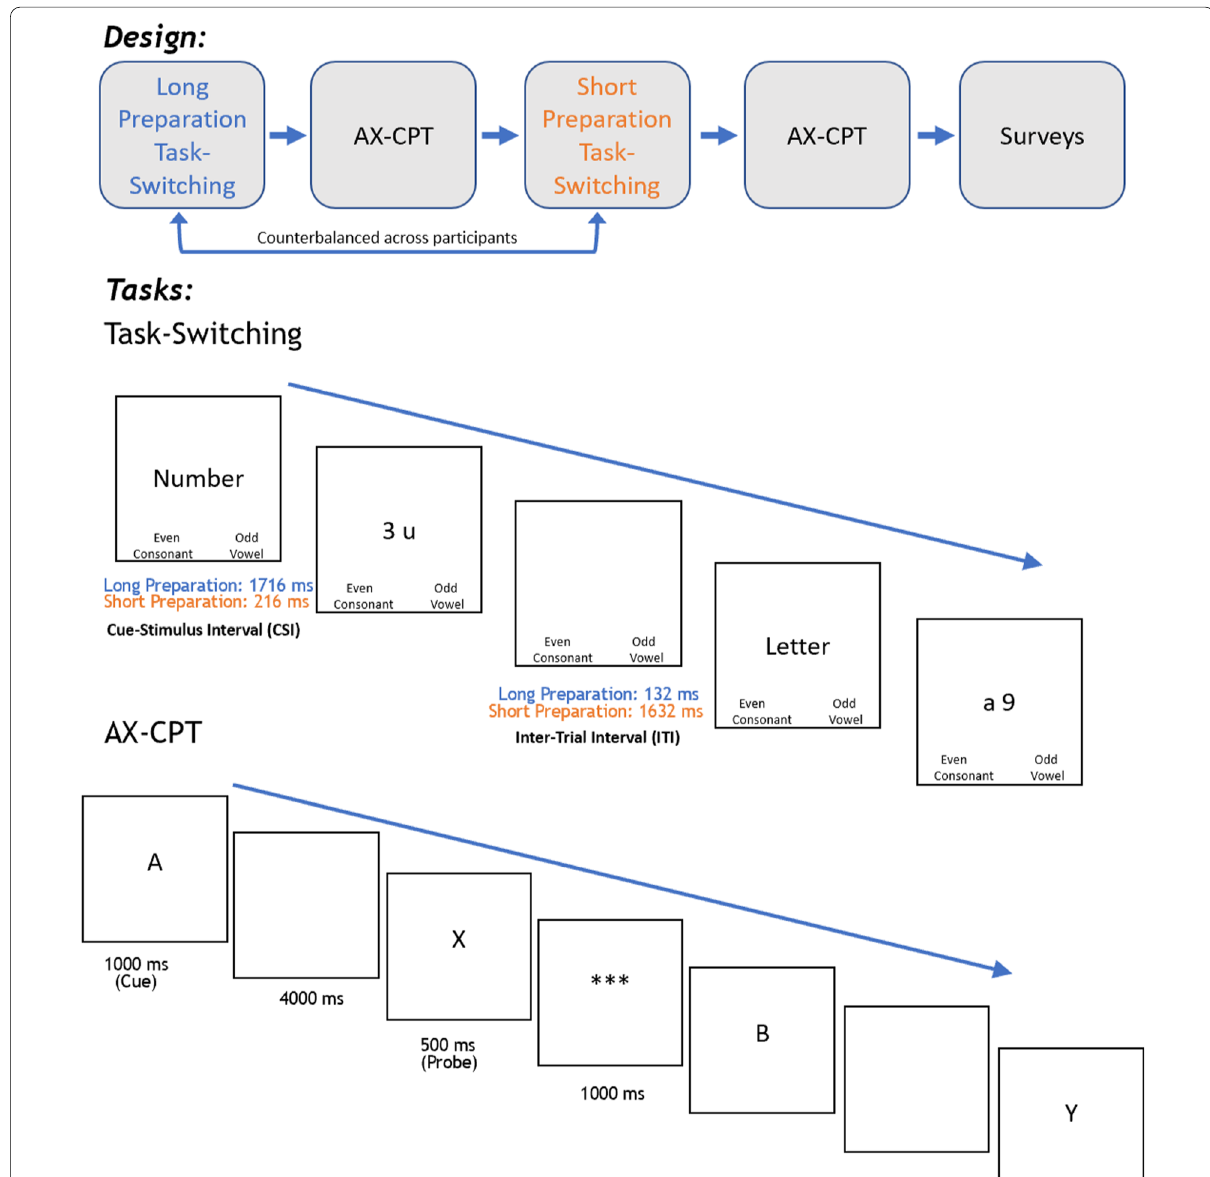
Fig. 1 Task design for the Pilot Study. Cue timings for the long preparation condition are indicated in blue text and in orange text for the short preparation condition. Inter-trial interval denotes time period after participant makes a response and before the cue for the next trial is presented (i.e., response-cue